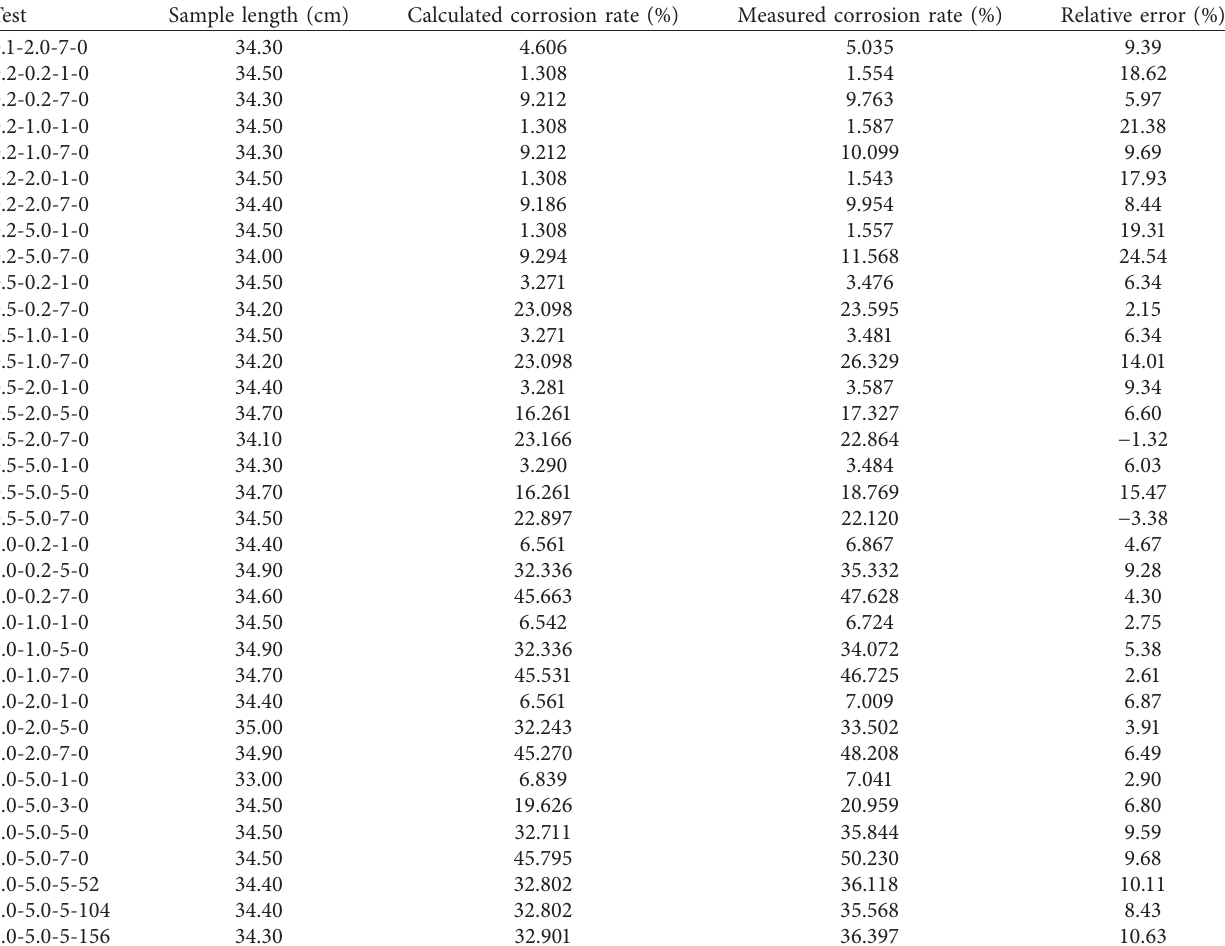
Table 3: Results of anchor cable electrolytic corrosion test.